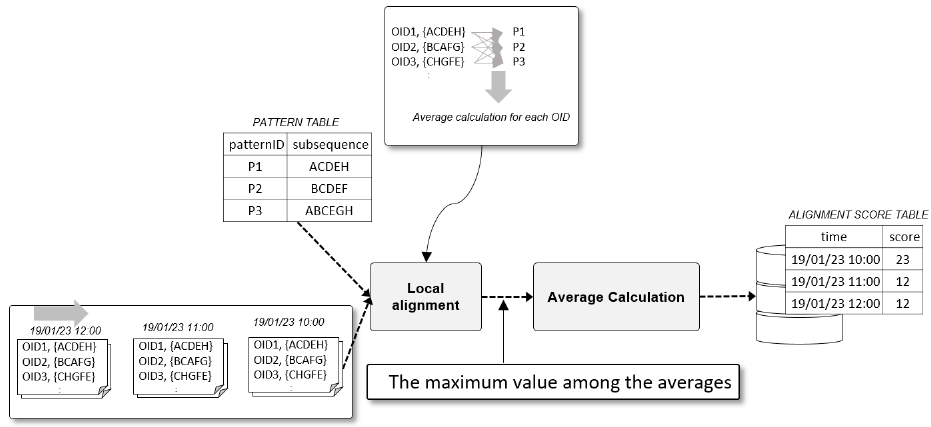
Figure 11. Result of Local alignment .